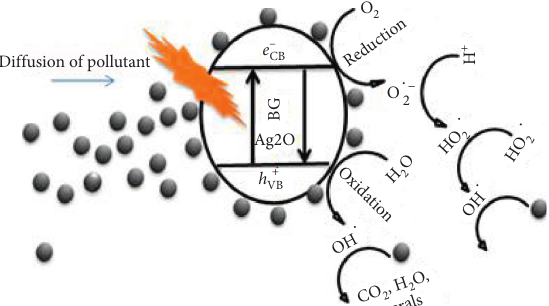
Figure 1: Schematic representation of photocatalytic